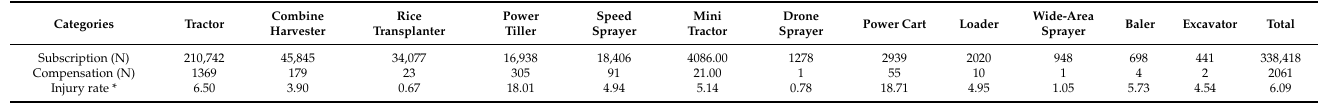
Table 1. Incidence rate of injuries related to agricultural machines among subscribers from 2014 to 2019.